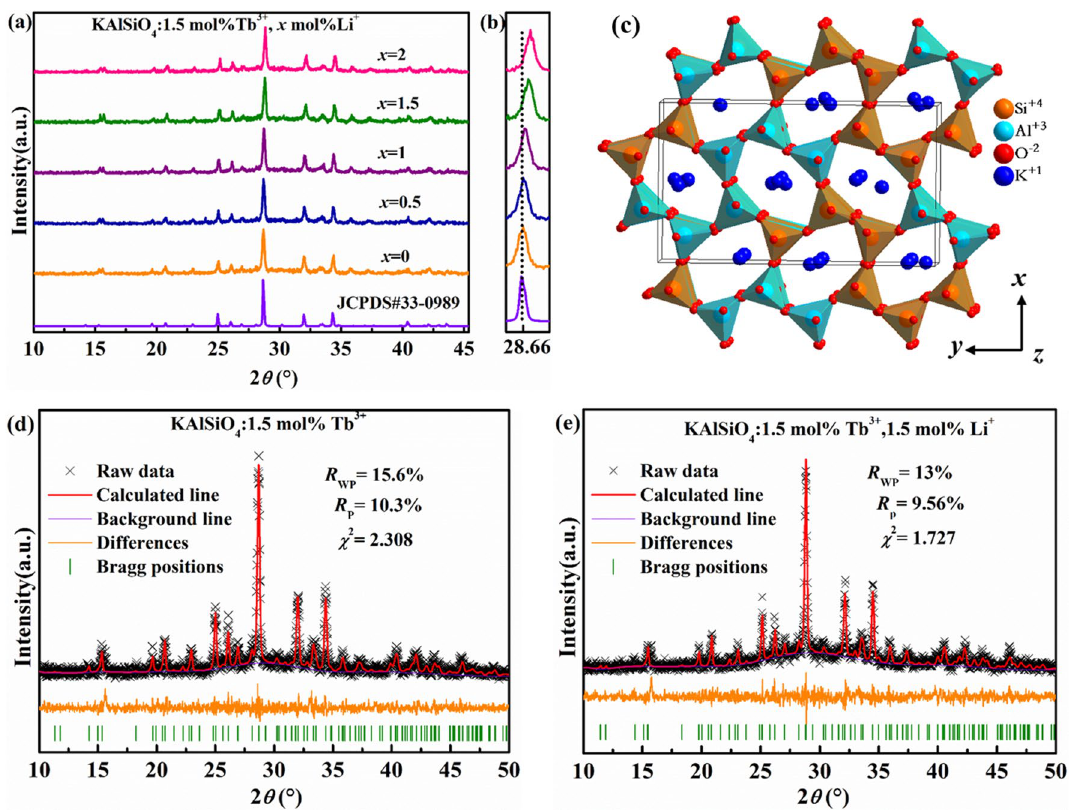
Figure 1. ( a , b ) X-ray diffraction pattern of KAlSiO 4 :1.5 mol% Tb 3+ , x mol% Li + . ( c ) Crystal structure of KAlSiO 4 . ( d ) Refined XRD image of KAlSiO 4 :1.5 mol% Tb 3+ and ( e ) KAlSiO 4 :1.5 mol% Tb 3+ , 1.5 mol% Li +